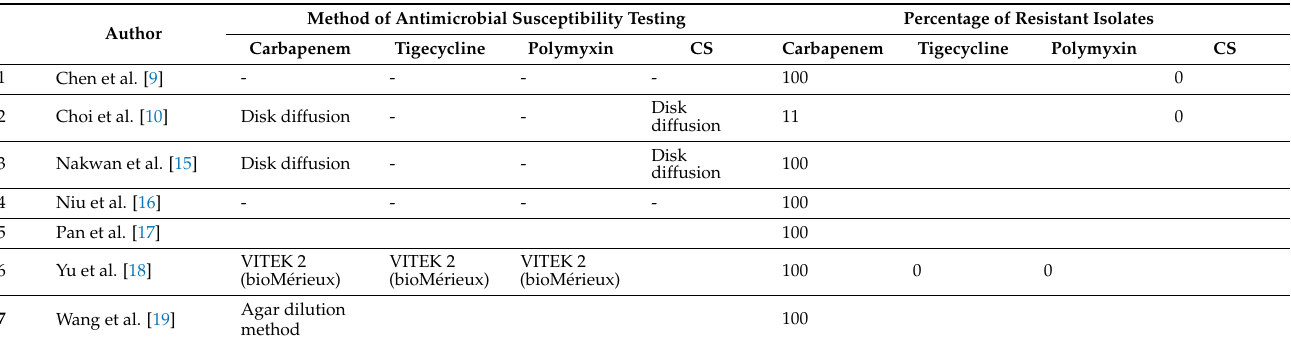
Table 3. Method of antimicrobial susceptibility in studies where cefoperazone-sulbactam was used